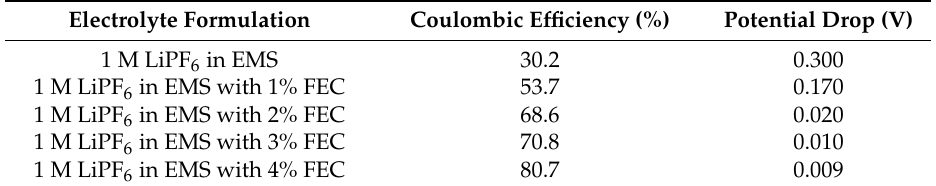
Table 1. Coulombic efficiency values and measured potential drop between the charge and the discharge curve of the first cycle of the graphite/Li cells depicted in Figure 1. Electrolyte Formulation Coulombic Efficiency (%) Potential Drop (V)